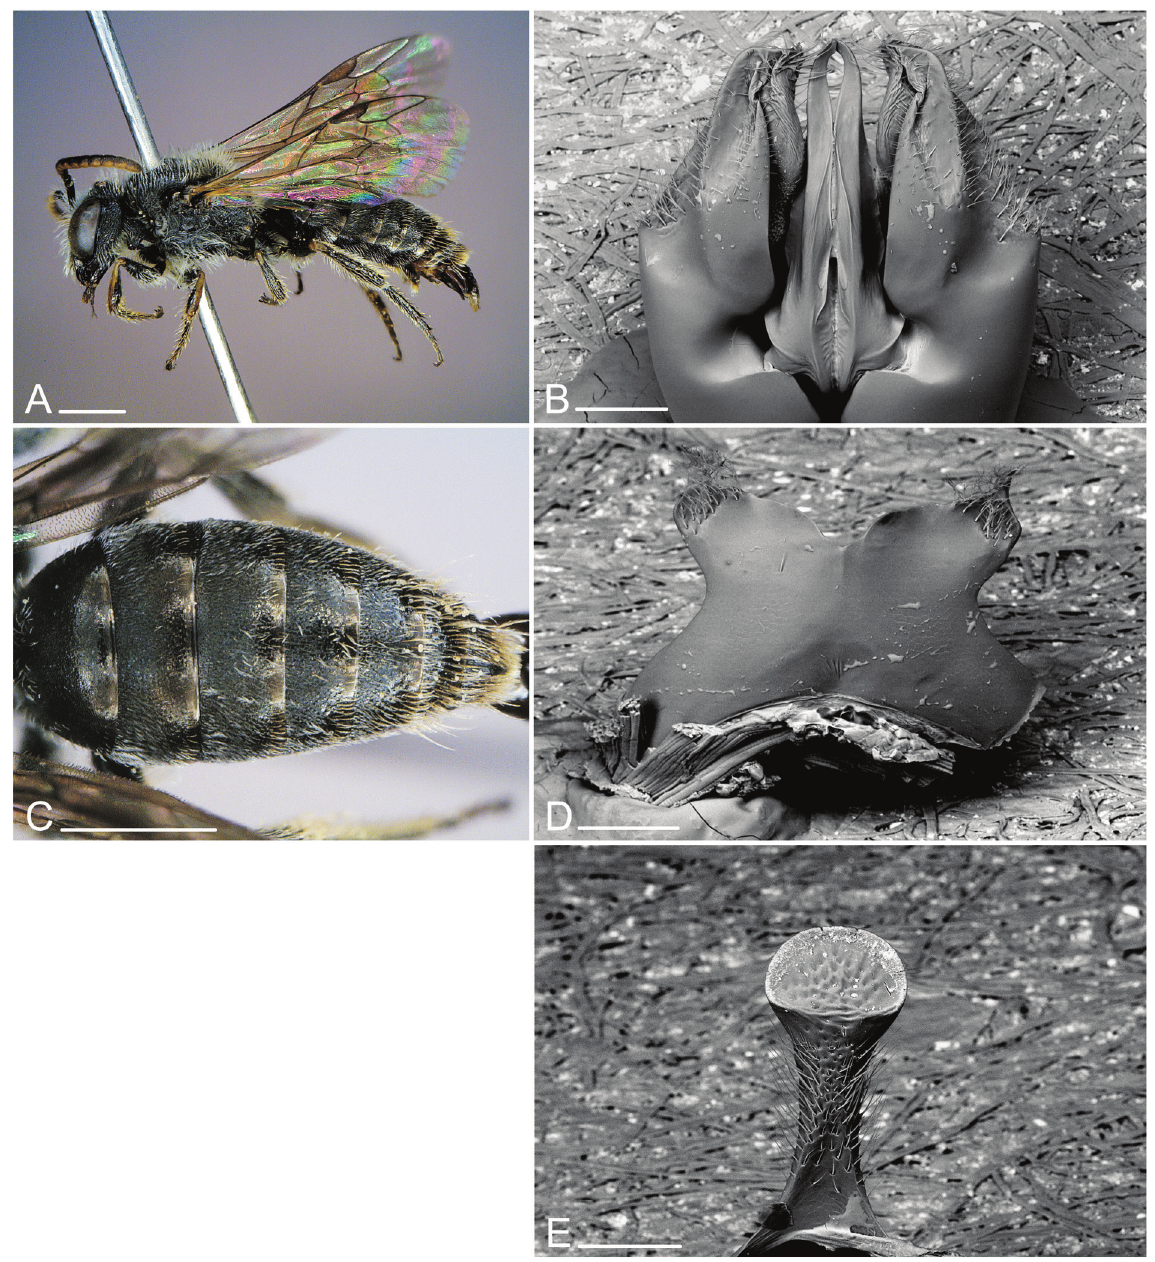
Fig. 33. Scrapter ulrikae sp. nov., ♂. A . Lateral view. B . Genitalia (dorsal view, SEM). C . Metasoma (dorsal view). D . S7 (dorsal view, SEM). E . S8, apical end (SEM). Scale bars: photos: 1 mm, SEM: 0.1